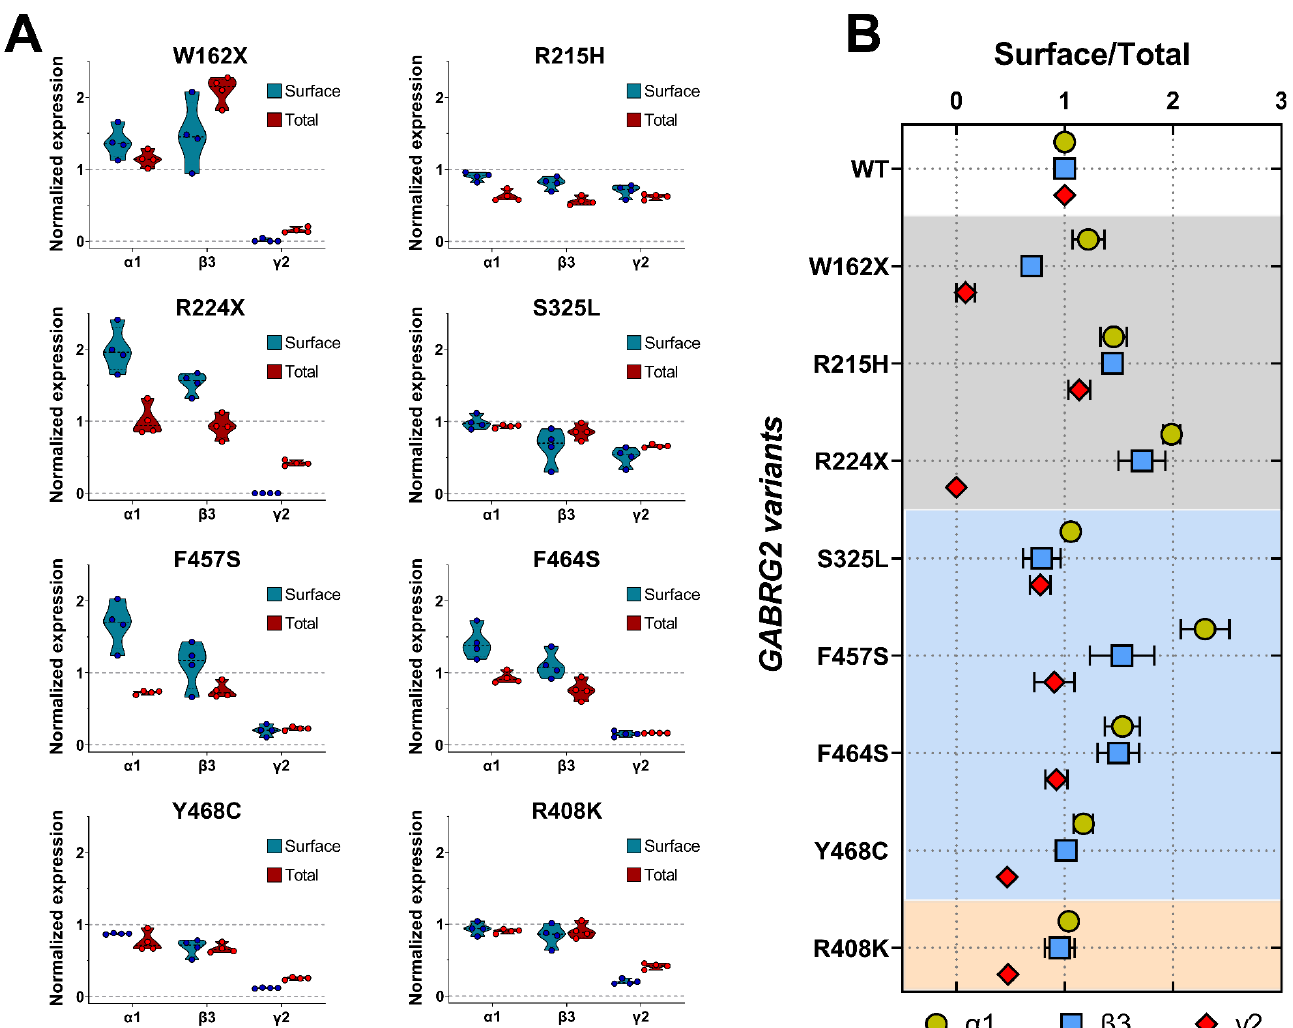
Figure 6. Mutant γ2 subunits changed the composition of GABA A receptors. ( A ) Wild-type or mutant γ2 subunits were co - transfected with α1β3 in HEK293T cells. Surface proteins were biotinylated and pulled down with streptavidin beads. Pulled-down proteins were separated by SDS-PAGE and probed with anti- α1, anti - β3, anti - γ2, or anti -ATPase antibodies. Total cell lysates (pull-down input) were collected, analyzed by SDS-PAGE, and equally blotted by anti- α1, anti - β3, anti - γ2, and anti - ATPase antibodies. Surface and total expression of GABA A Rs containing mutant γ2 subunits were normalized to WT α1β3γ2 subunits. Numerical data are reported as mean ± S.E.M. A summary of the data is shown in Table 5. ( B ) Surface/total expression ratios were determined as the fraction of surface to total altered GABA A R subunit, as an indicator of the magnitude of the negative or positive effect of the presence of mutant γ2 subunits. Numerical data are reported as mean ± S.E.M. Some error bars cannot be displayed as they are smaller than the symbol size. The data were summarized in Table 6.